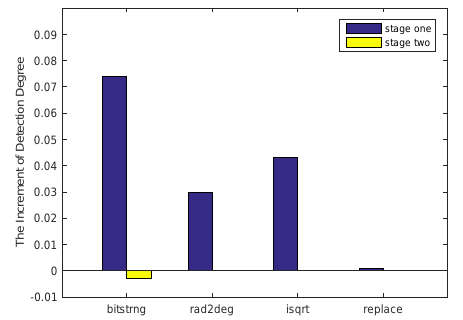
Figure 11. The increment of detection